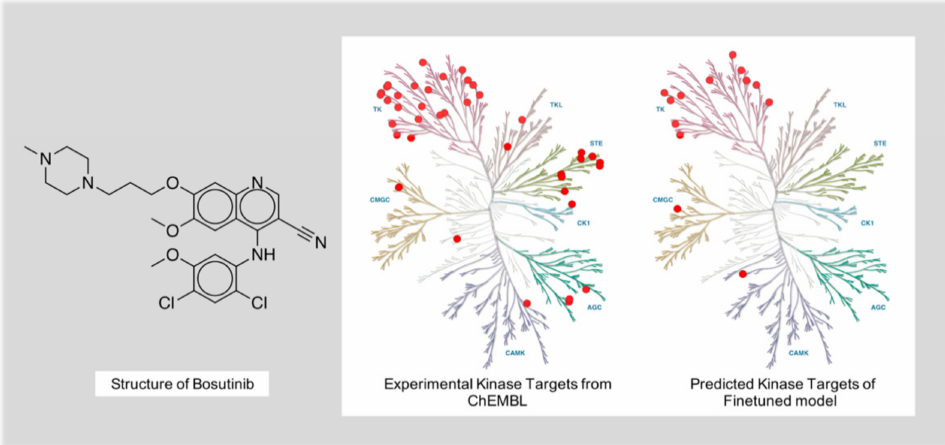
Figure 9. The experimental kinase targets and predicted kinase targets of